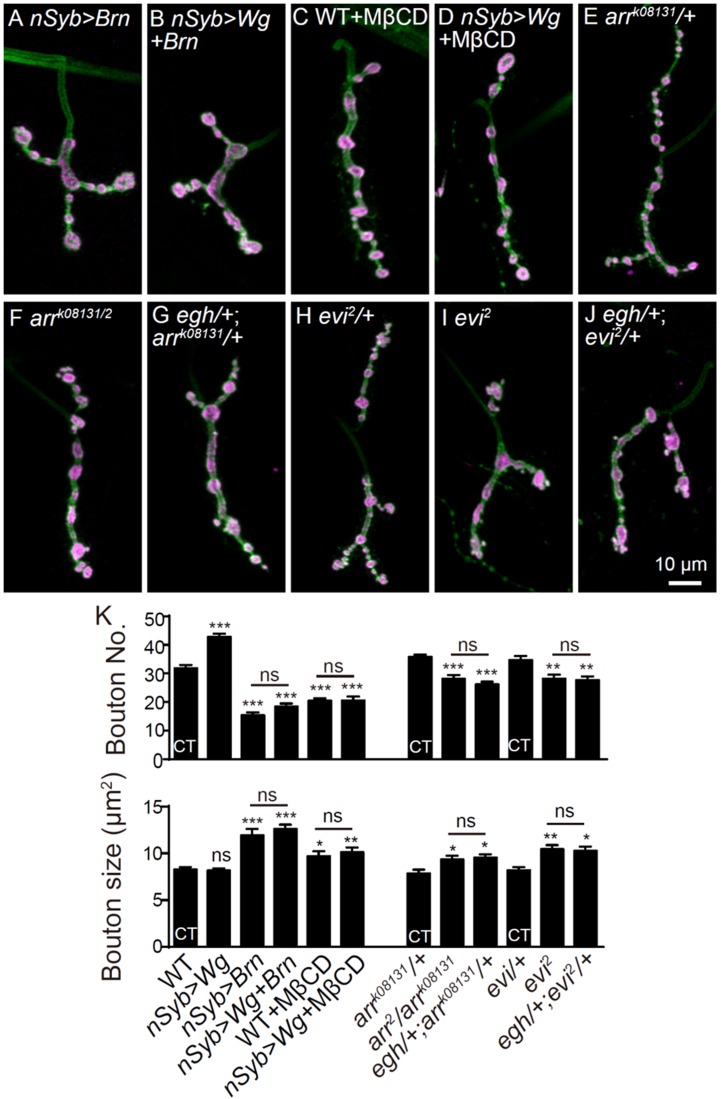
Additional NMJ images and quantifications.